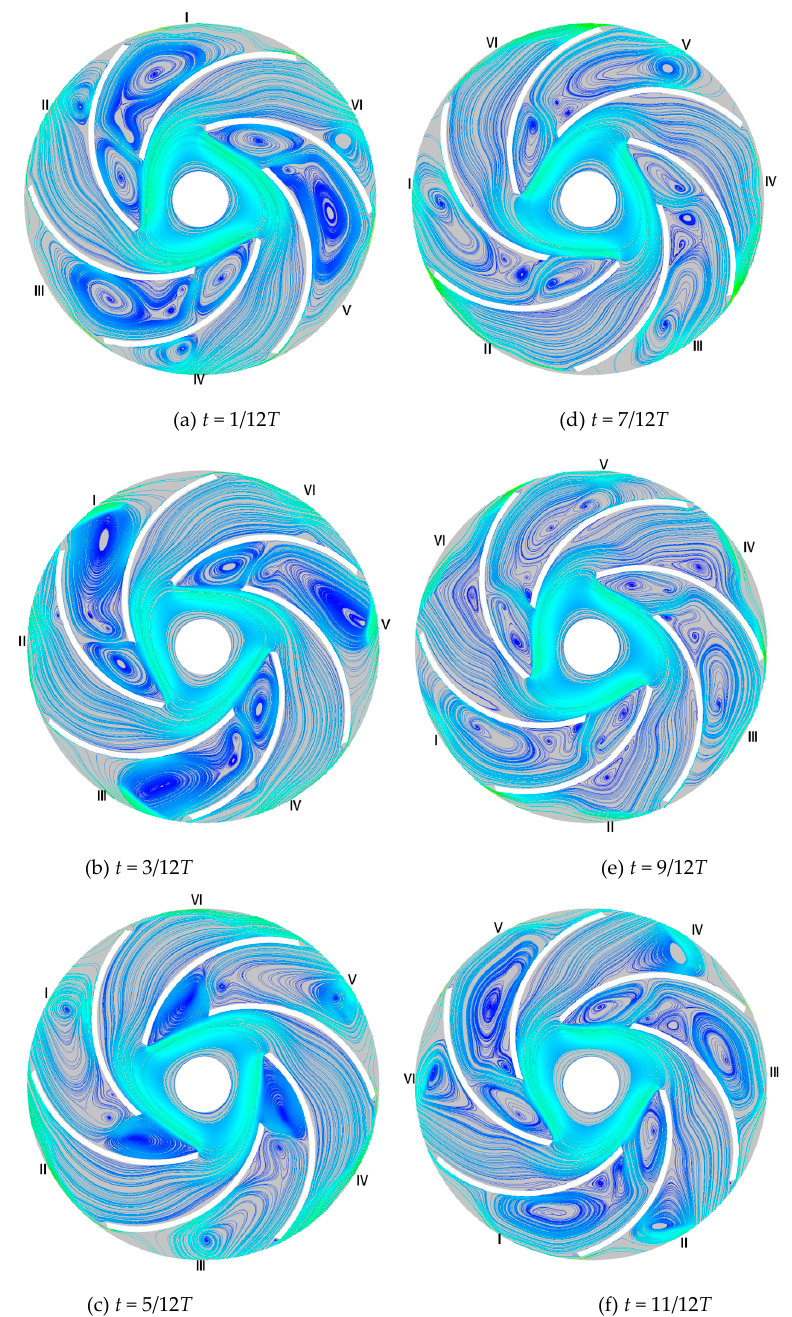
Figure 4. Evolution of streamlines with the rotation of the impeller at different moments within one cycle: the streamlines are colored by the velocity magnitude.